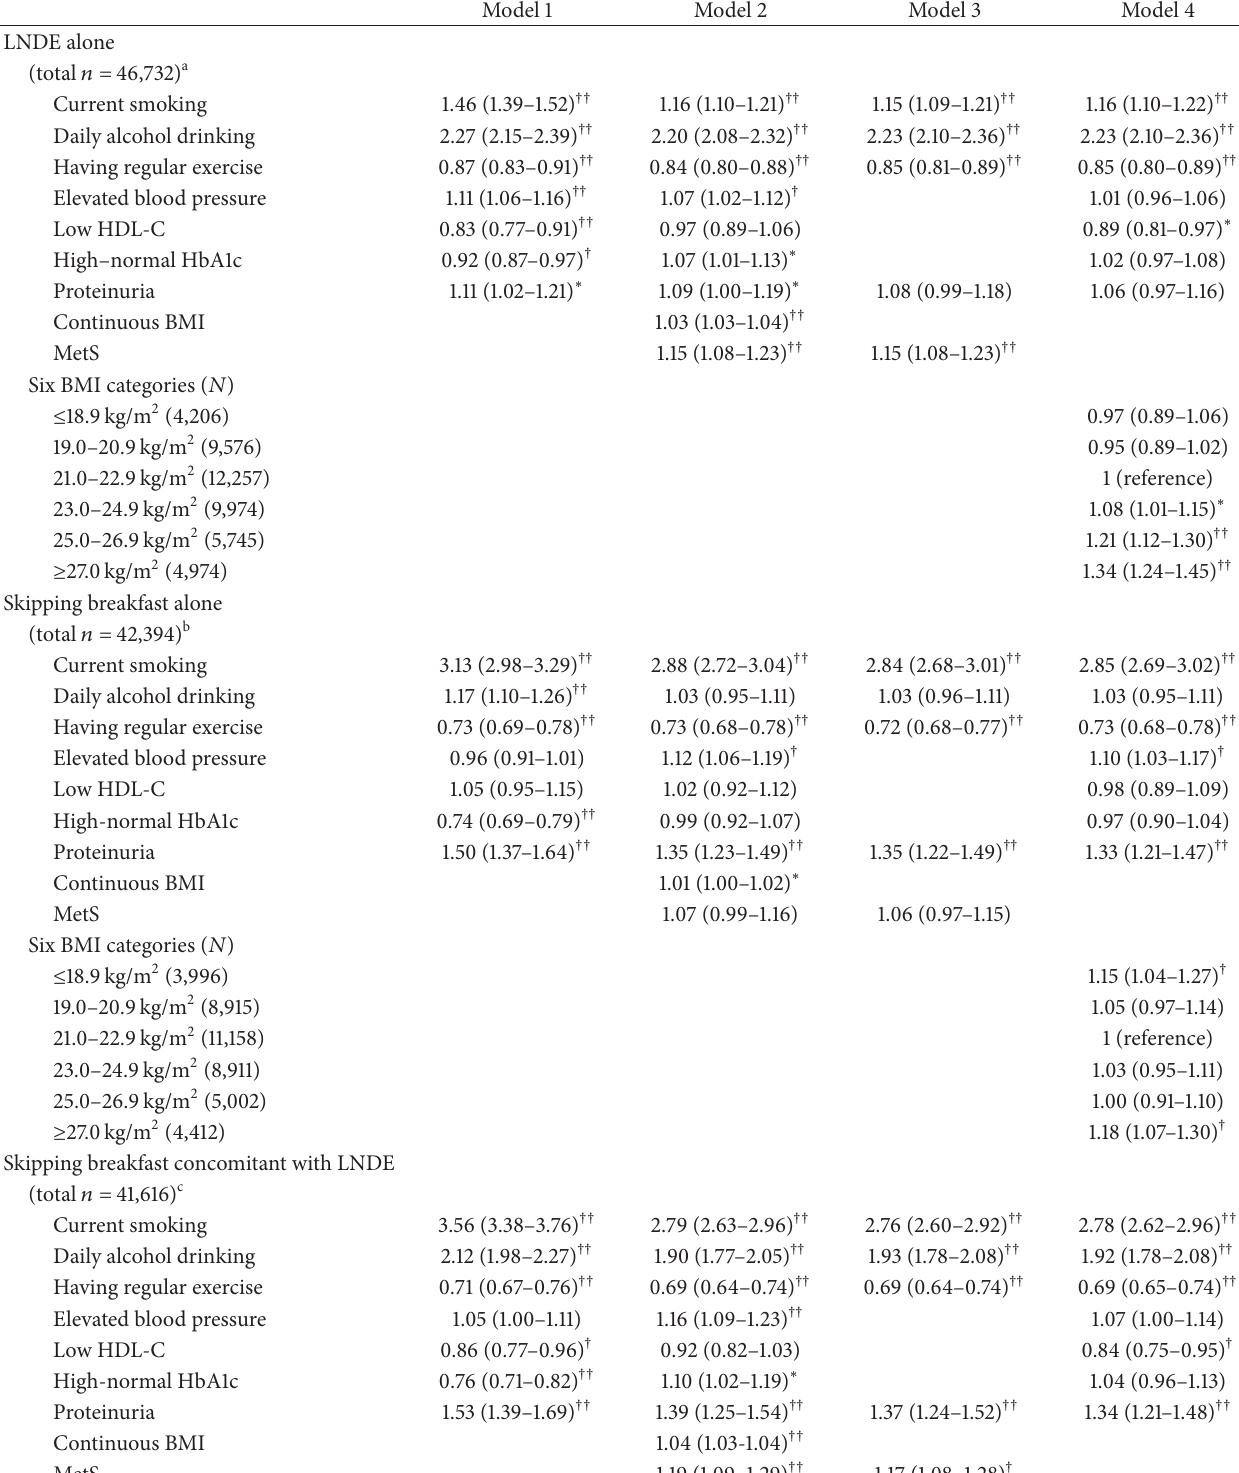
Table 3: Odds ratios and 95% CIs of unhealthy eating behaviors for cardiometabolic